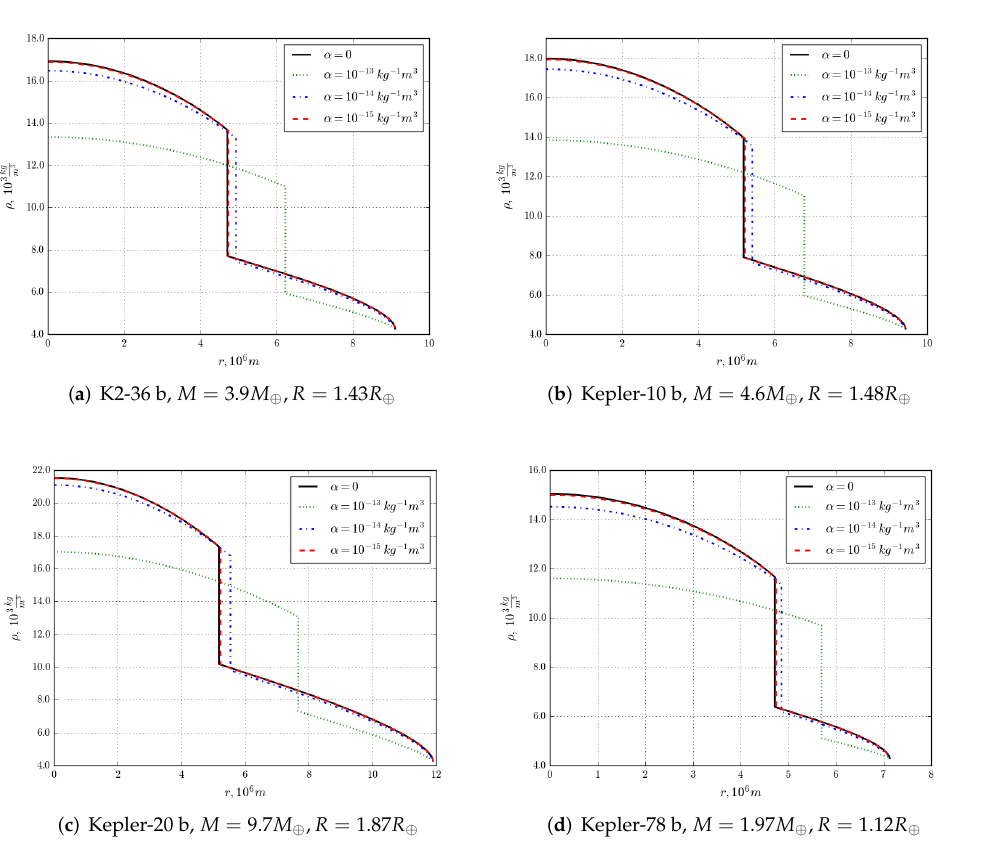
Figure 1. Density profiles for four different Earth-like exoplanets, for different values of the parameter α = c 2 κ 2 β . The planets are assumed to be composed of two layers: iron core, and mantle made of (Fe, Mg)SiO 3